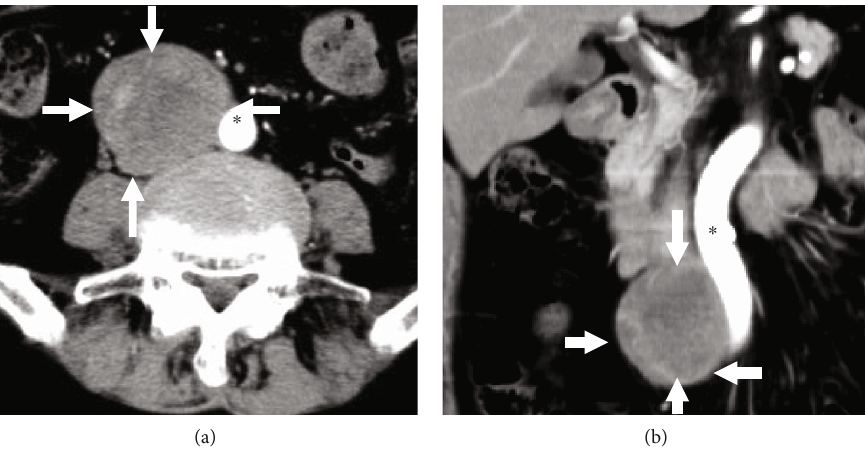
Figure 1: Computed tomography (CT) images at the recurrence revealed a large tumor (arrows) in the retroperitoneum, which was crossed to the aorta ( ∗ ). (a) Horizontal section and (b) coronal section.